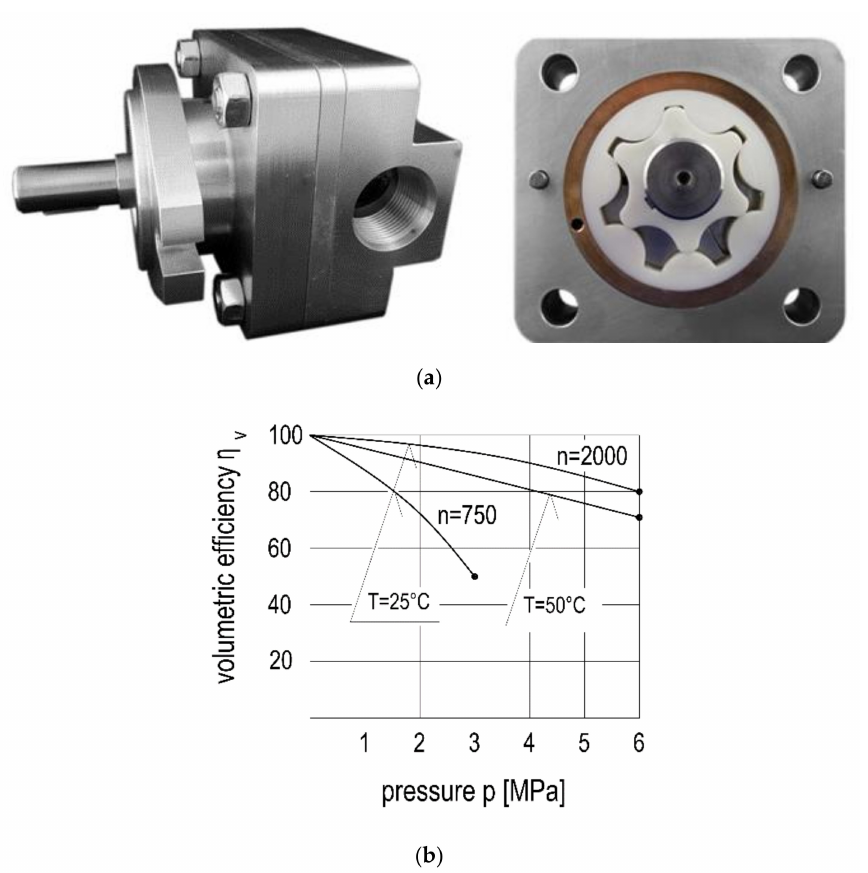
Figure 16. Experimental gerotor pump with plastic epicycloidal gearing: ( a )—view of the pump; ( b )—volumetric efficiency η v